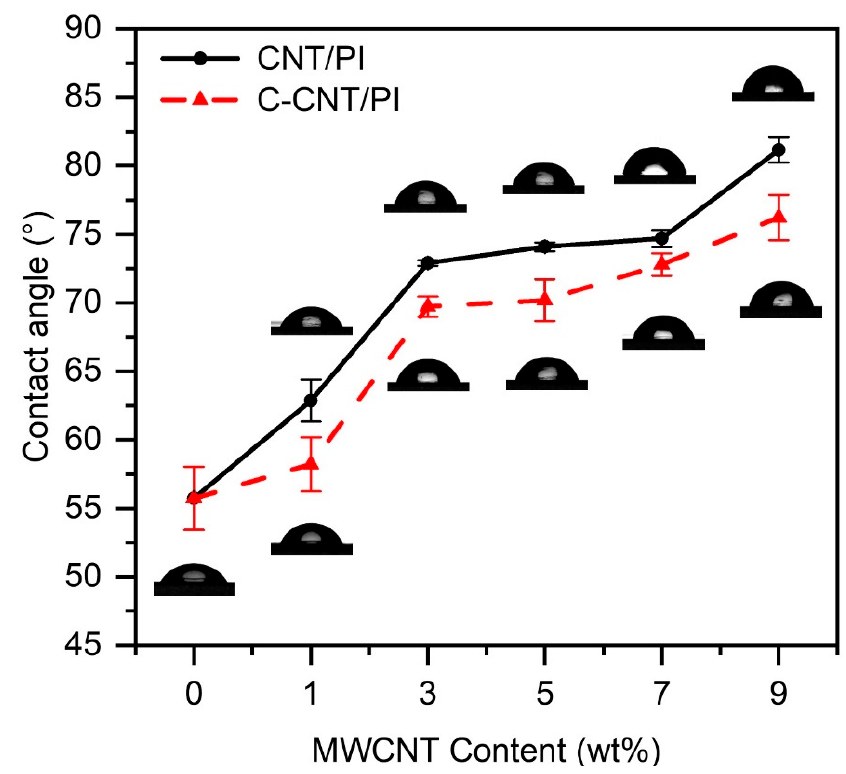
Figure 4. Summary of water contact angle measurements for PI, CNT/PI and C-CNT/PI films.